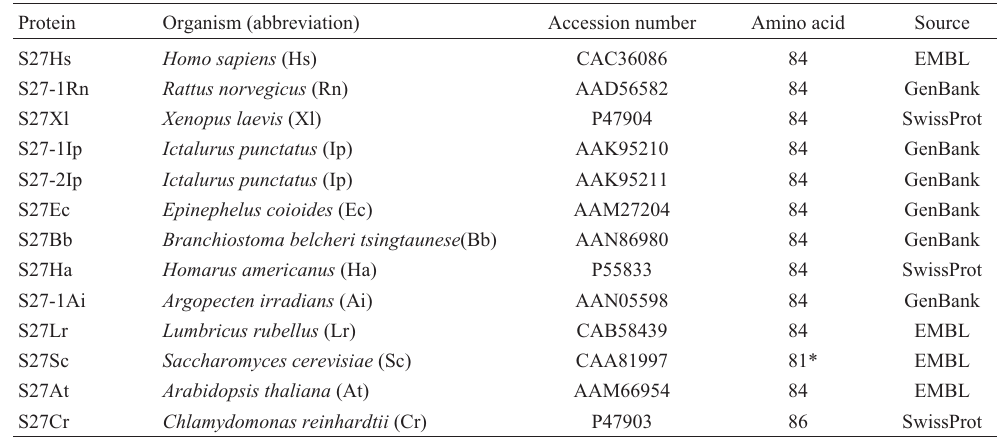
Table 1 - Representative members of the S27 ribosomal protein